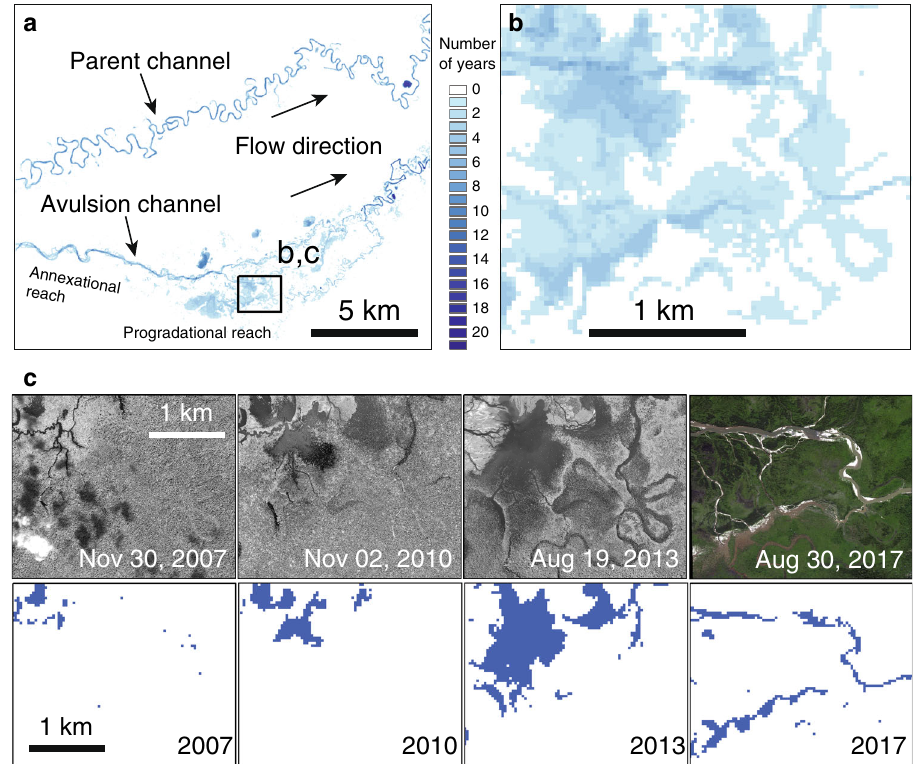
Fig. 2 Qualitative validation of the avulsion fi ngerprinting process. a Avulsion fi ngerprint map of the central part of avulsion B12 (Moleto River, Bolivia). Inset square shows area used in the validation process. Number of years corresponds to the number of times a given pixel is included in the avulsion fi ngerprint. b Close-up of the avulsion fi ngerprint map over the area of interest used for validation. c Four years showing high-resolution satellite imagery (upper row) and the corresponding single year avulsion fi ngerprints (lower row). Dark blue pixels represent detected avulsion pixels. The four successive fi ngerprints record the progradation of the crevasse splay associated with the avulsion. Note that more than just these fi ngerprints were used to calculate the fi ngerprint in b . Satellite images in c are World View 1 panchromatic images and World View 1 RGB images. Imagery Copyright 2017 DigitalGlobe,